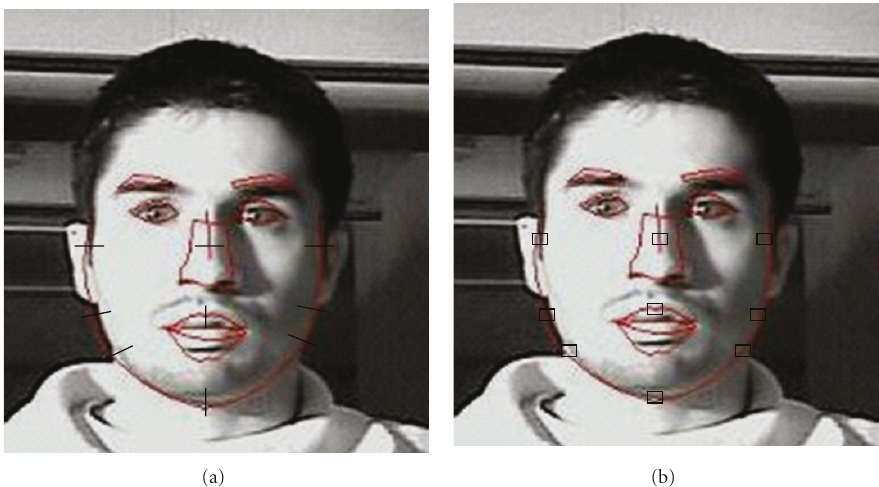
Figure 12: Profile constructionduring training is shown, to avoid clutter, for a few points along the boundary of the ASM model and one point each on the nose and the lips. We do the profiling for the entire set of 79ASM points on the face during training. (a) 1D profiles constructed using lines normal to the shape boundary at a keypoint (b) 2D profilesconstructed using square regions around each